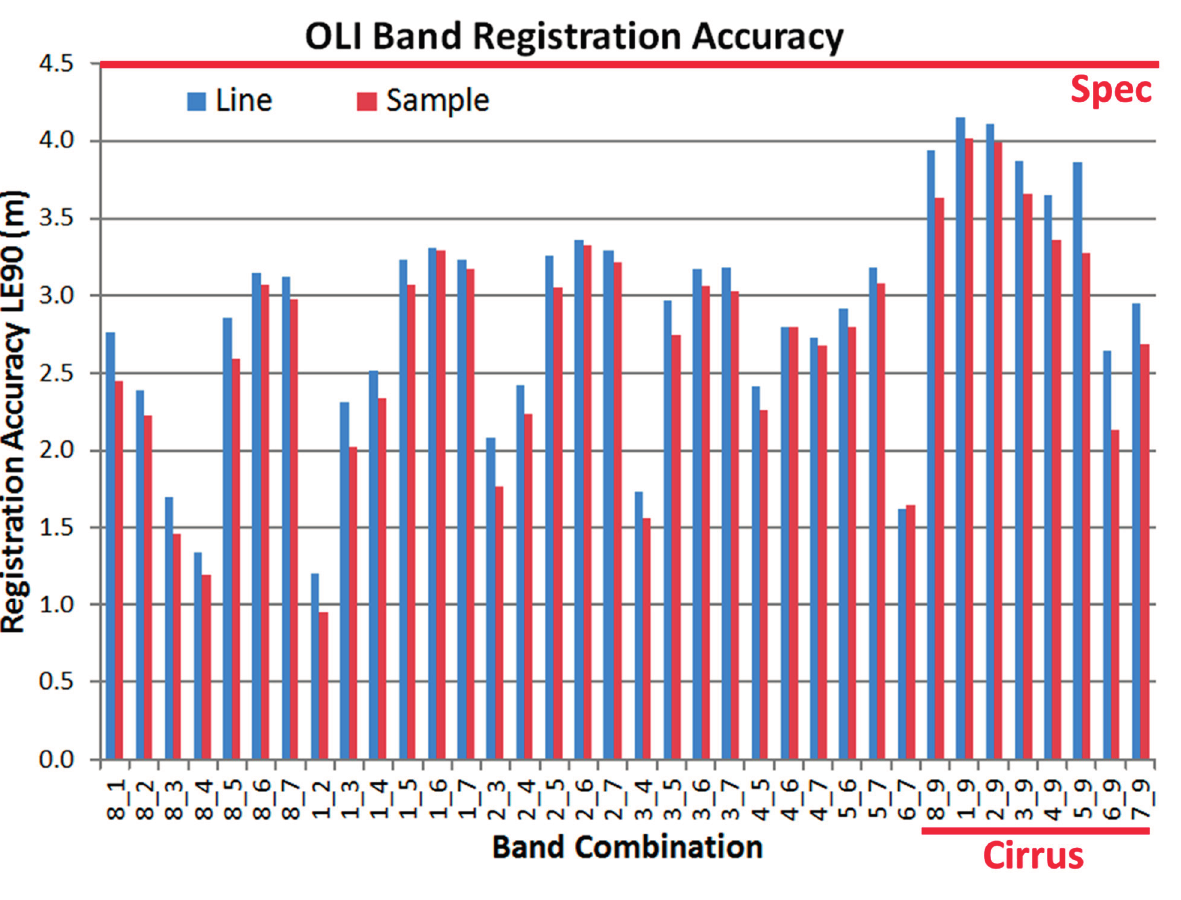
Figure 10. OLI band-to-band registration accuracy by band pair. Pairs including the cirrus band are grouped at the right end of the